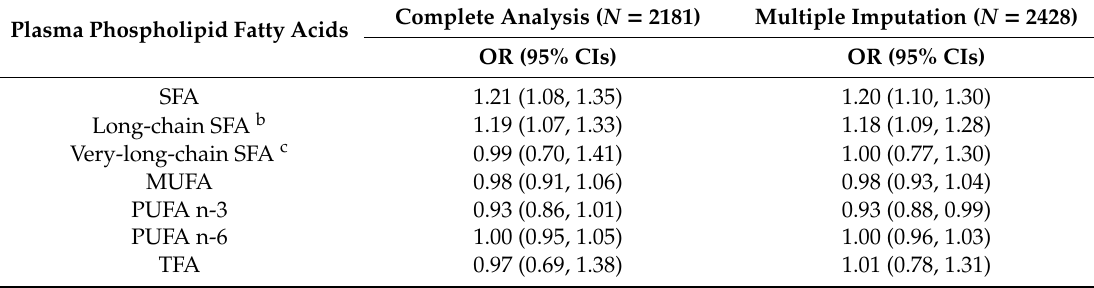
Table A5. Multivariable adjusted associations a (1 moL %) between plasma phospholipid fatty acids and CHD risk among participants with complete information versus using multiple imputation in the matched case-control study.